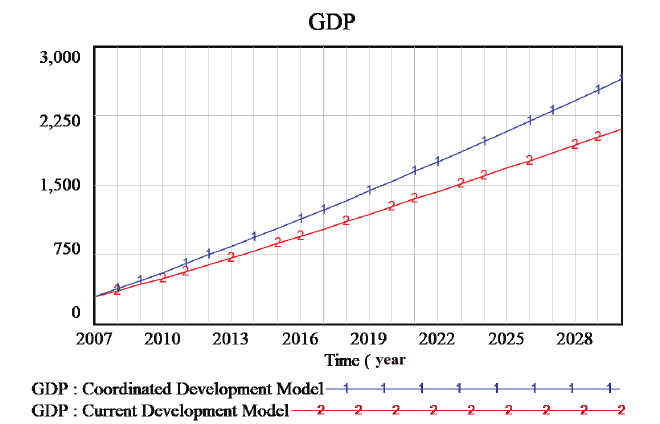
Fig. 4 GDP simulation value(One hundred million yuan)